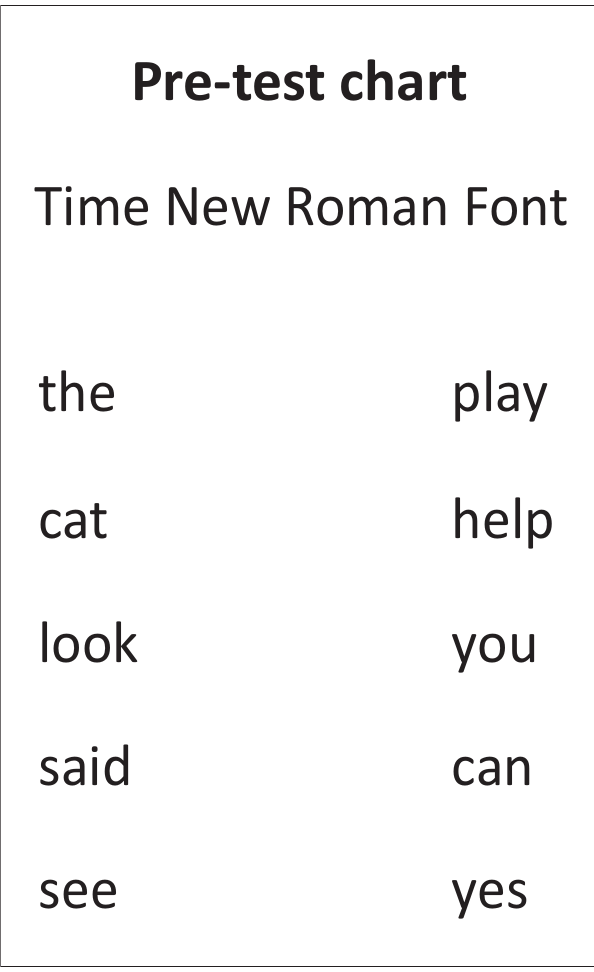
FIGURE 2: The paediatric rate of reading pre-test chart in Times New Roman